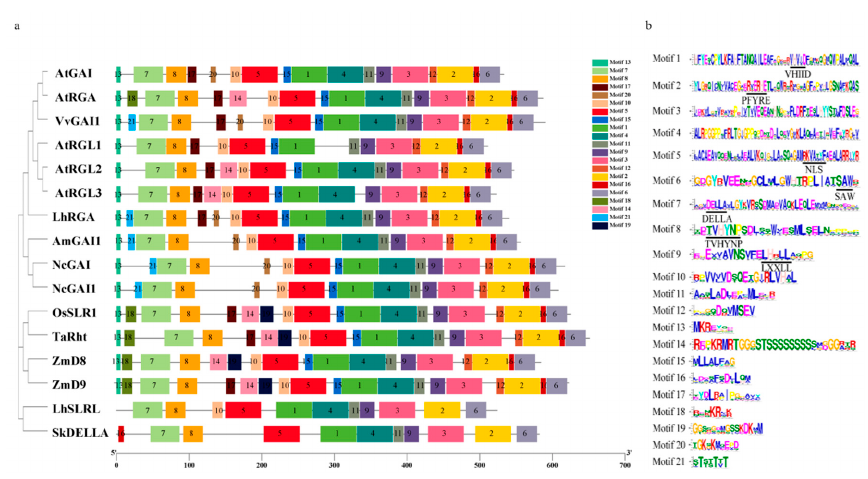
Figure 3. Structural analysis of LhDELLAs proteins. ( a , b ) Motifs identified ( a ) and their positions ( b ) in 16 DELLA proteins from nine different plant species. Different colors correspond to different motifs. The total height of each stack indicates the sequence conservation at that position, and the height of the symbol in each stack reflects the relative frequency of the corresponding amino acid (MEME motif search tool).